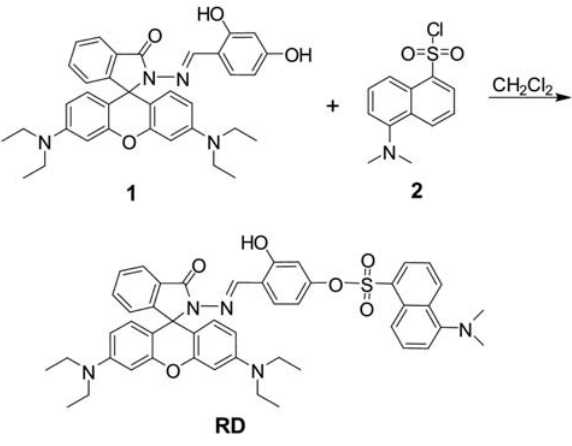
/I ) as a func- 580 545